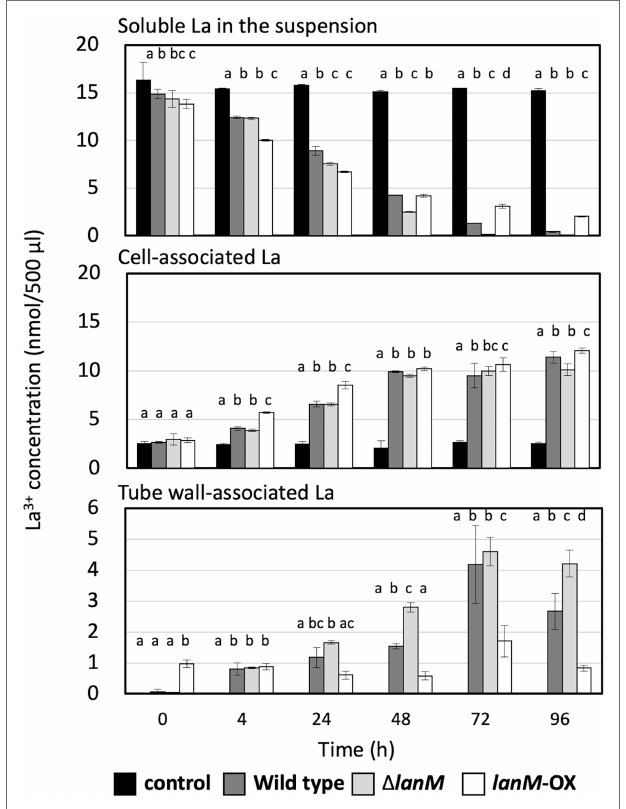
FIGURE 7 | Time-dependent changes of the soluble La in the suspension, cell-associated La, and tube wall–associated La in the cell suspensions of the wild type, Δ lanM , and Δ lanM (pAT01-P fae1 - lanM ). The details of the experiment are included in the “Materials and Methods”. Data are presented as the mean value ± standard deviation (SD), two-way ANOVA with a Tukey’s multiple comparisons test and compact letter display ( p < 0.05, n = 3).